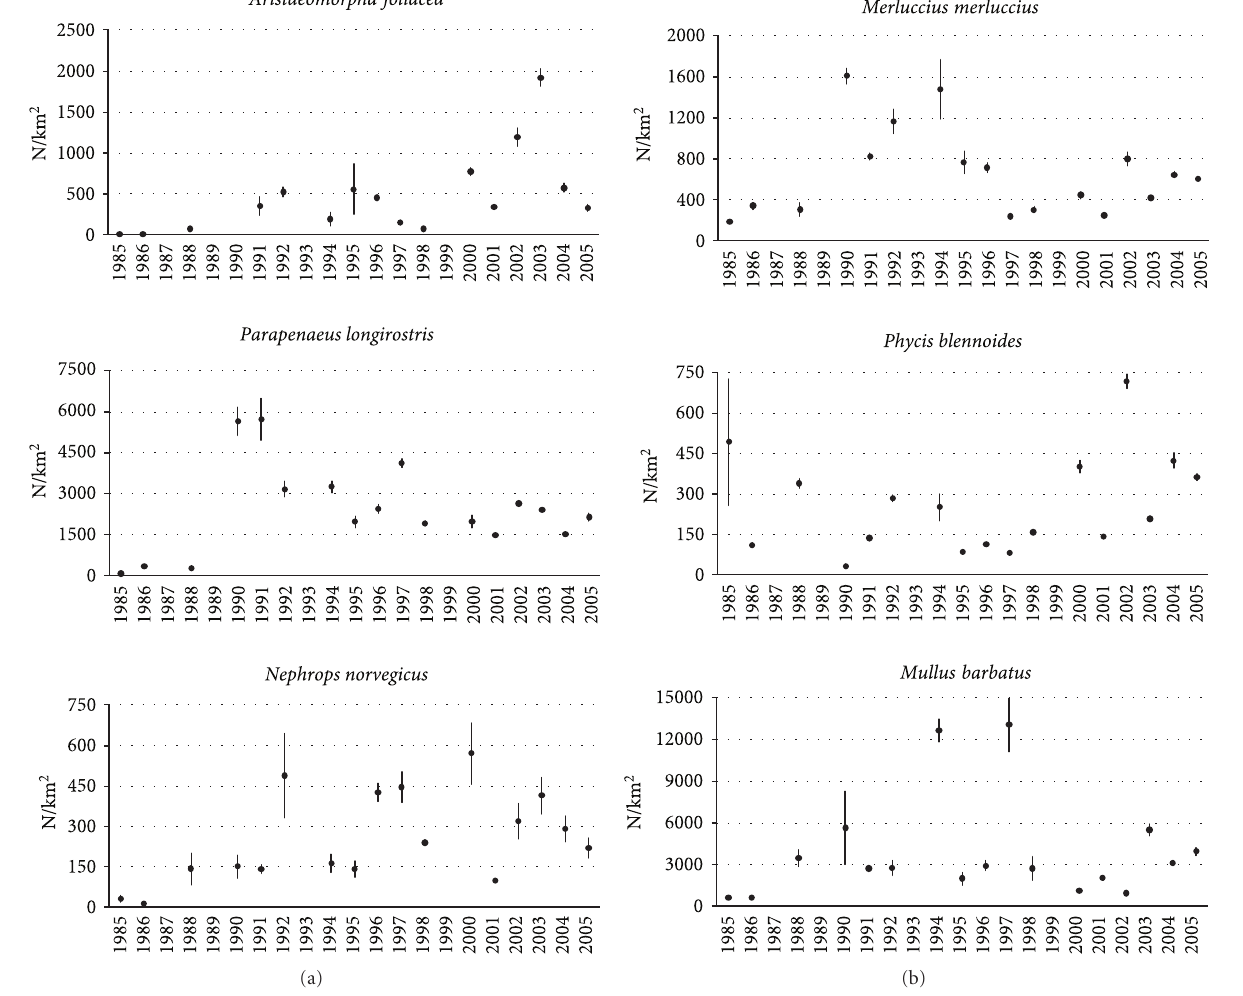
Figure 5: (a) Density indices with standard deviation in crustacean species caught from 1985 to 2005 in the north-western Ionian Sea. (b) Density indices with standard deviation in fish species caught from 1985 to 2005 in the north-western Ionian